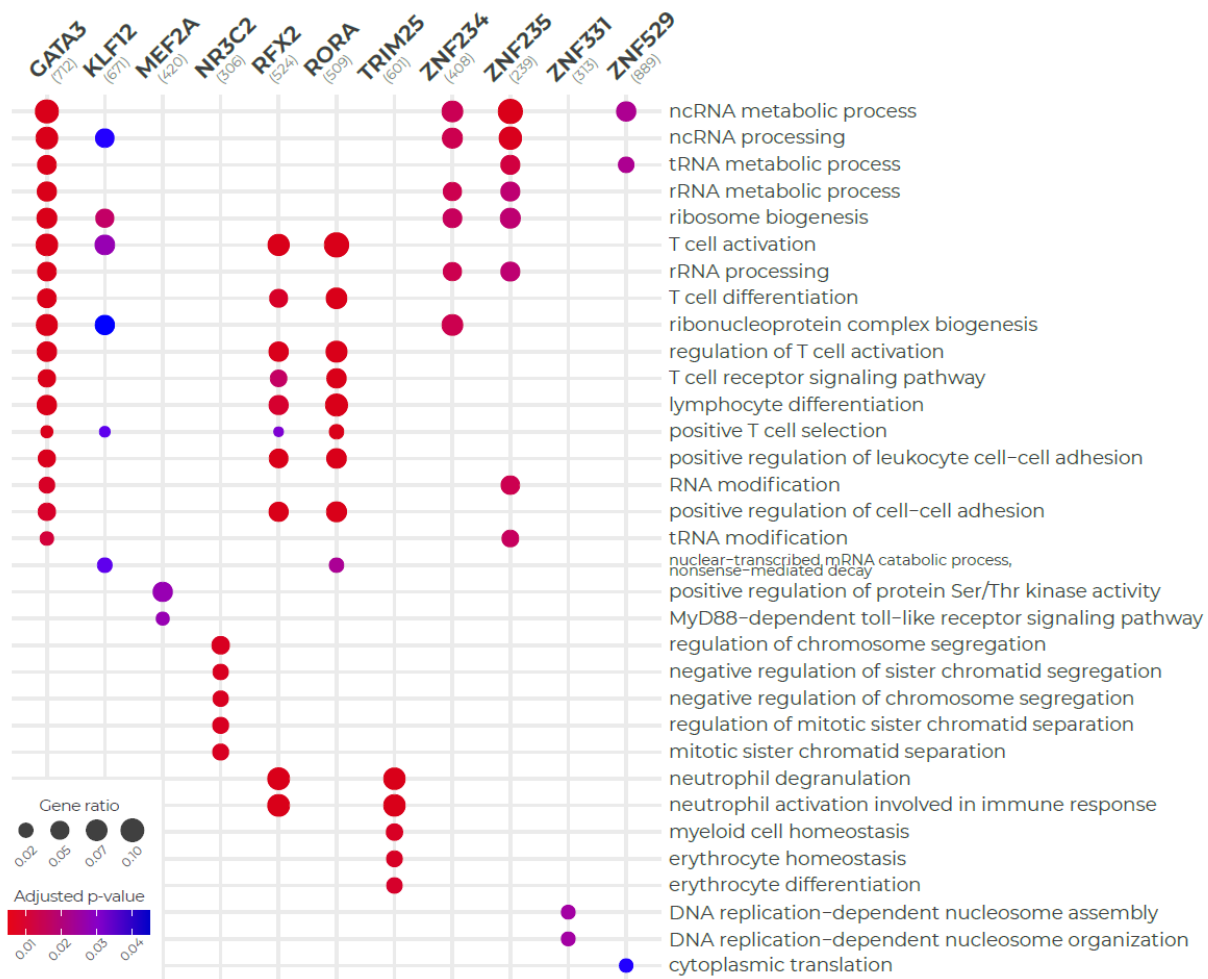
Figure 5. Gene ontology functional enrichment of regulons using clusterProfileR. Each column shows the main biological functions performed by 11 out of the 15 regulons, with a p -value < 0.05, adjusted by Benjamini-Hochberg correction. Regulons within this analysis consist of the union of genes regulated by each master regulator in both Pediatric Sepsis 1 and 2 networks.